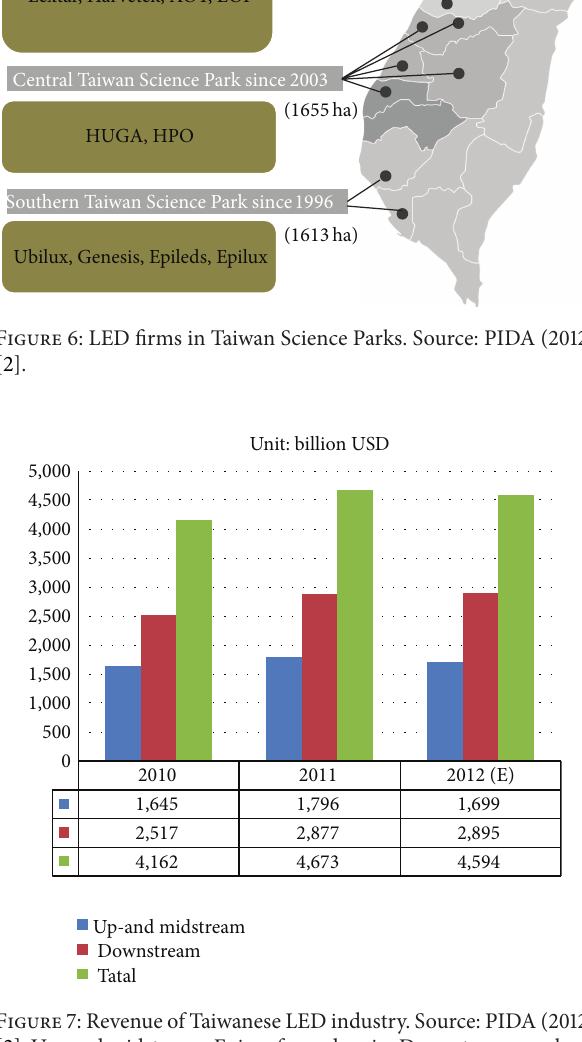
Figure 7: Revenue of Taiwanese LED industry. Source: PIDA (2012) [2]. Up- and midstream: Epi-wafer and grain. Downstream: package and